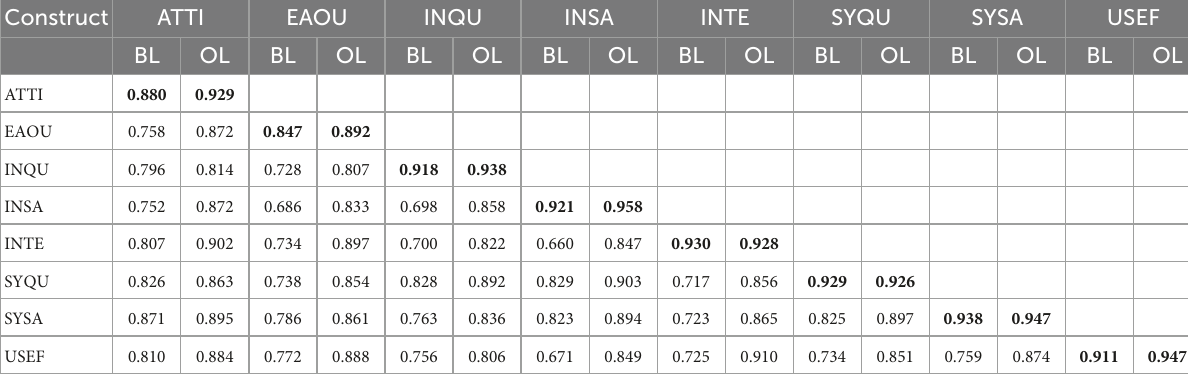
TABLE 2 Discriminant validity of the research models of BL and OL.